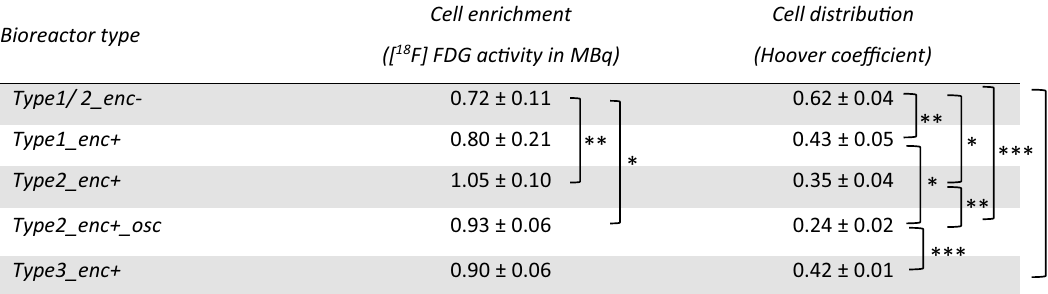
Table 2. Measurement of cell enrichment and homogeneity of the cell distribution within different bioreactor types by dynamic micro-PET/CT after 60 min perfusion. Cell enrichment was calculated by detecting [ 18 F] FDG-labeled cells. Homogeneity of cell distribution was presented by calculating the Hoover coefficient, whereby a lower Hoover coefficient indicates higher homogeneity of cell distribution in the scaffold (mean ±